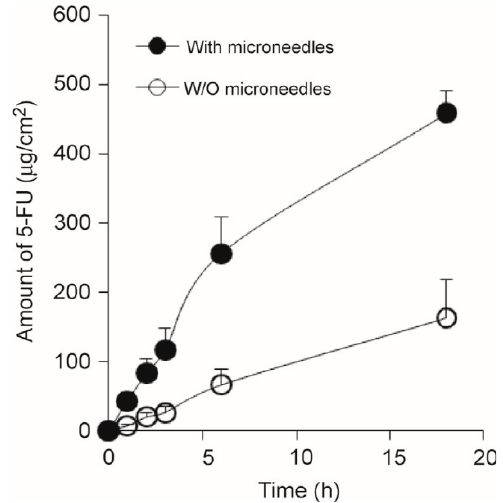
Figure 11. The amount of 5-FU in an aqueous solution diffused through full-thickness mouse skin treated ( ● ) or not treated ( ◌ ) with MNs as a function of time, reproduced with permission from [256], Elsevier, 2013.